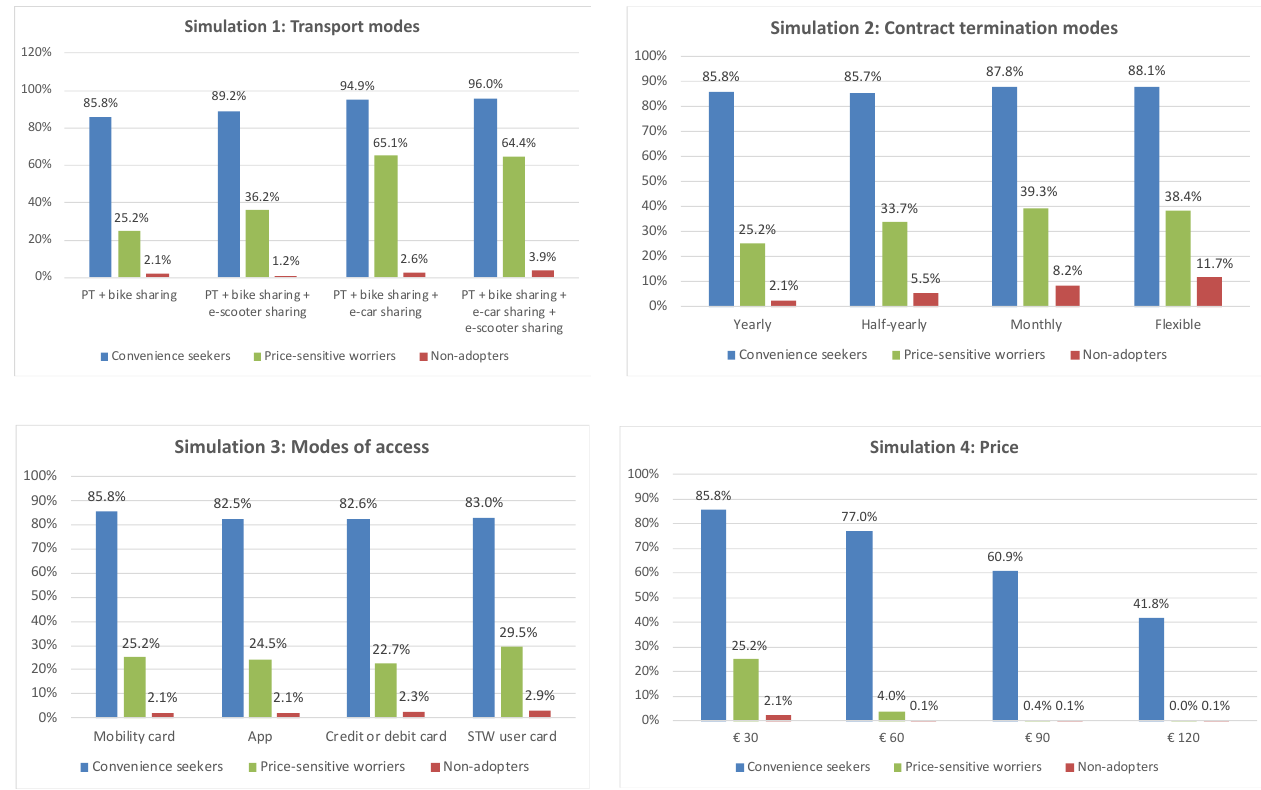
Figure 4. Summary of market simulations on segment level (% of respondents).